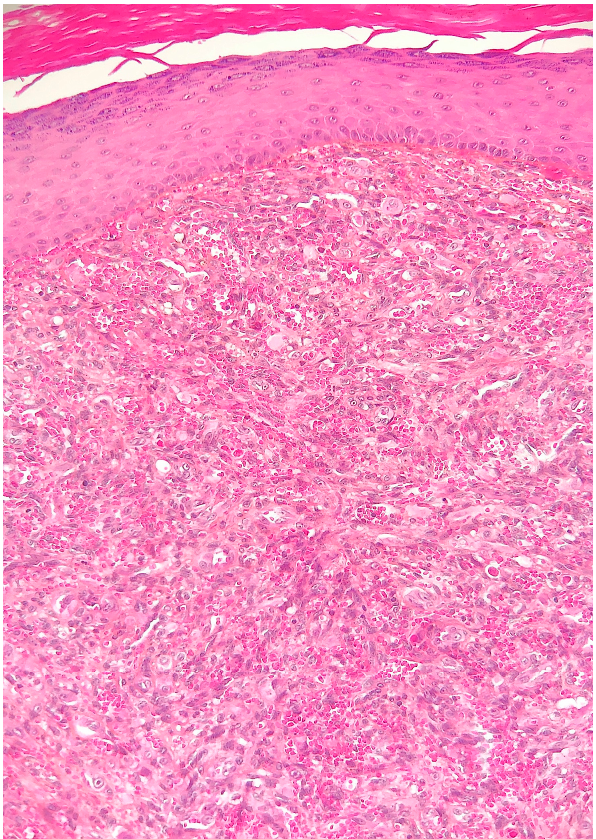
Figure 2. Scanning view of the lesion: well-demarcated, dermal nodule, surrounded by an epider- mal collarette (haematoxylin–eosin–saffron stain).